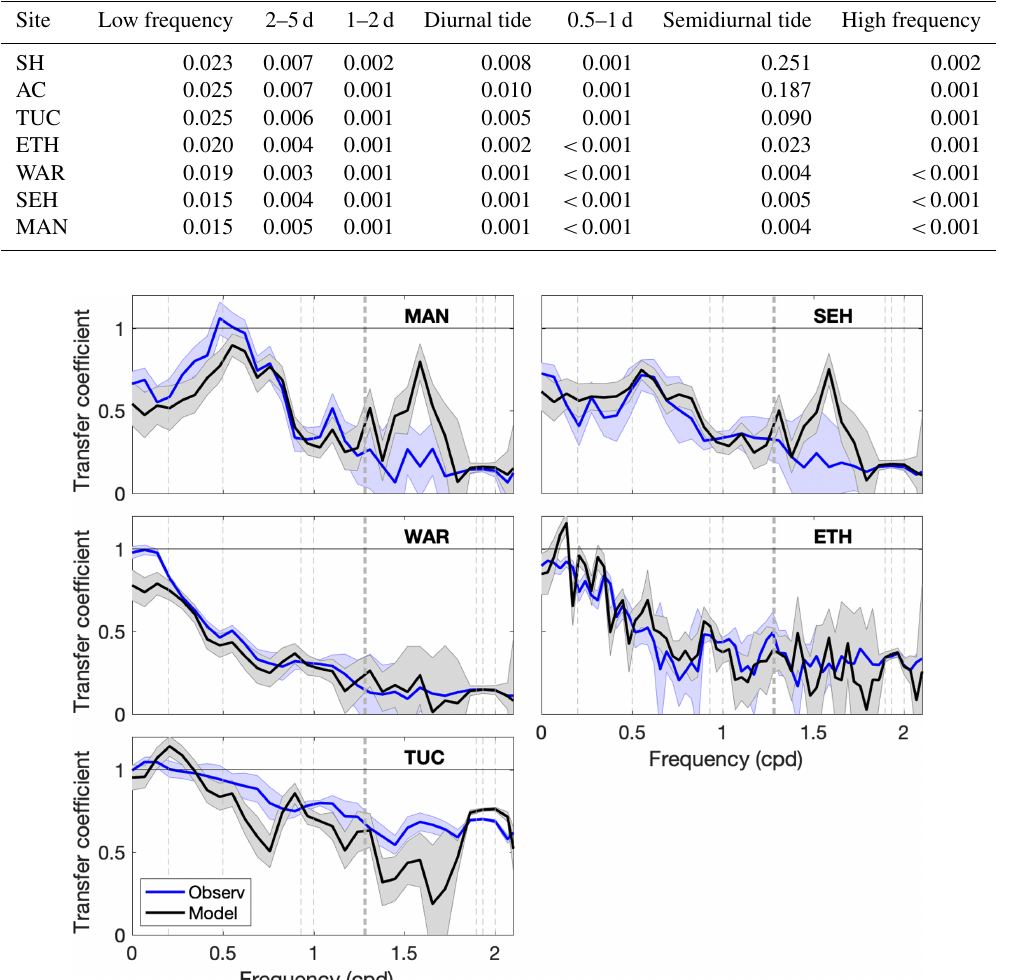
Figure 5. Comparison between observed (blue) and numerical model (black) transfers for the period when both are available (March– December 2012) at five bay stations. Uncertainty envelopes for the transfer coefficient (Bendat and Piersol, 1986) are provided for observed (light blue) and model (gray)